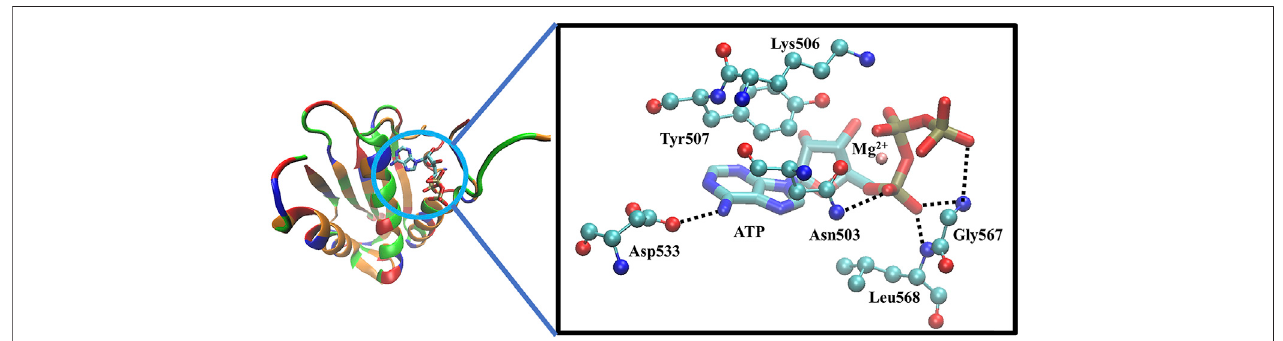
FIGURE4| TheX-raycrystalstructureoftheATP-bindingdomainofWalK(PDB:3SL2)(Celikeletal.,2012;Boibessotetal.,2016).Left:theoverviewofthebinding of ATP with WalK, in which the ATP is represented by sticks model and Walk is represented by a cartoon tube in which the basic residues are colored in blue, the acidic residues are colored in red, the polar residues are colored in green and the nonpolar residues are colored in orange. Right: The binding interactions between ATP (balls and sticks model) and the key residues on WalK (sticks model). Oxygen atoms are colored in red, nitrogen atoms are colored in blue, carbon atoms are colored in cyan, phosphate atoms are colored intan, and Mg 2+ arecolored in orange. Hydrogenbonds are represented bydotted lines,and chelation withMg 2+ isrepresented by orange